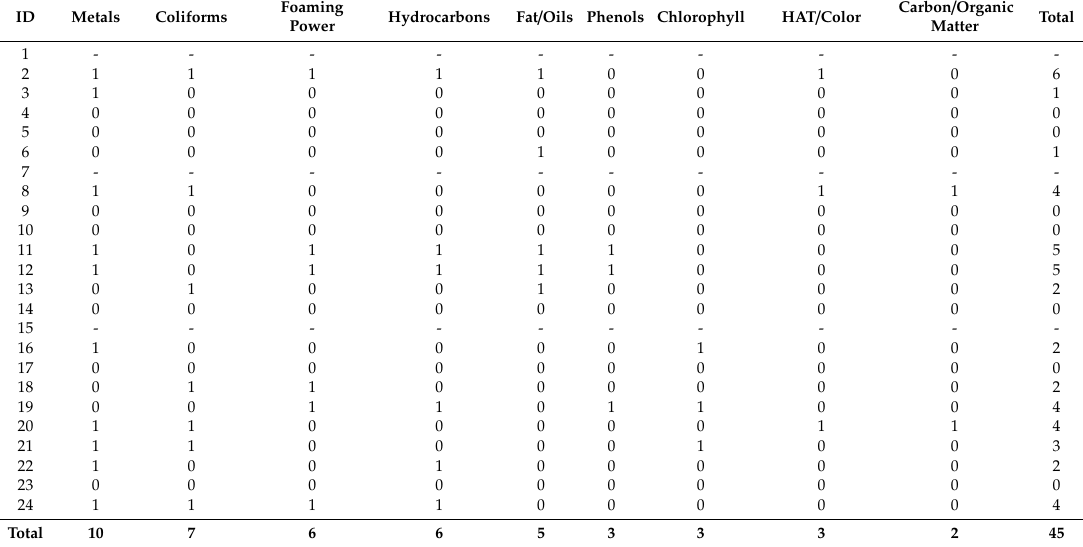
Table A2. Irrelevant descriptors identified in the seawater